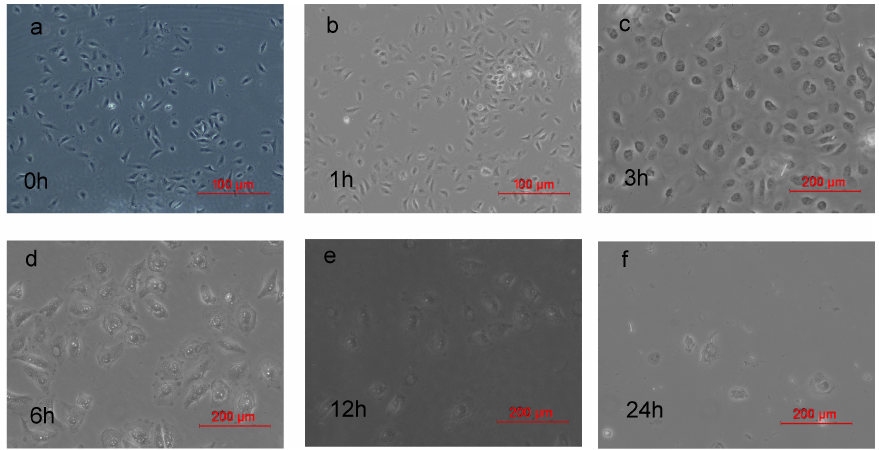
Figure 5. Morphological changes of HeLa cells incubated with 30 μ M BPHM after PDT: ( a ) 0 h; ( b ) 1 h; ( c ) 3 h; ( d ) 6 h; ( e ) 12 h; ( f ) 24 h.